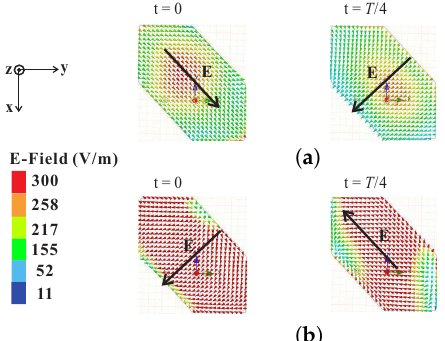
Figure 5. Simulated electric field distributions at the top of a hexagonal DR with time period T at frequencies of ( a ) 2.32 GHz; and ( b ) 3.2 GHz.